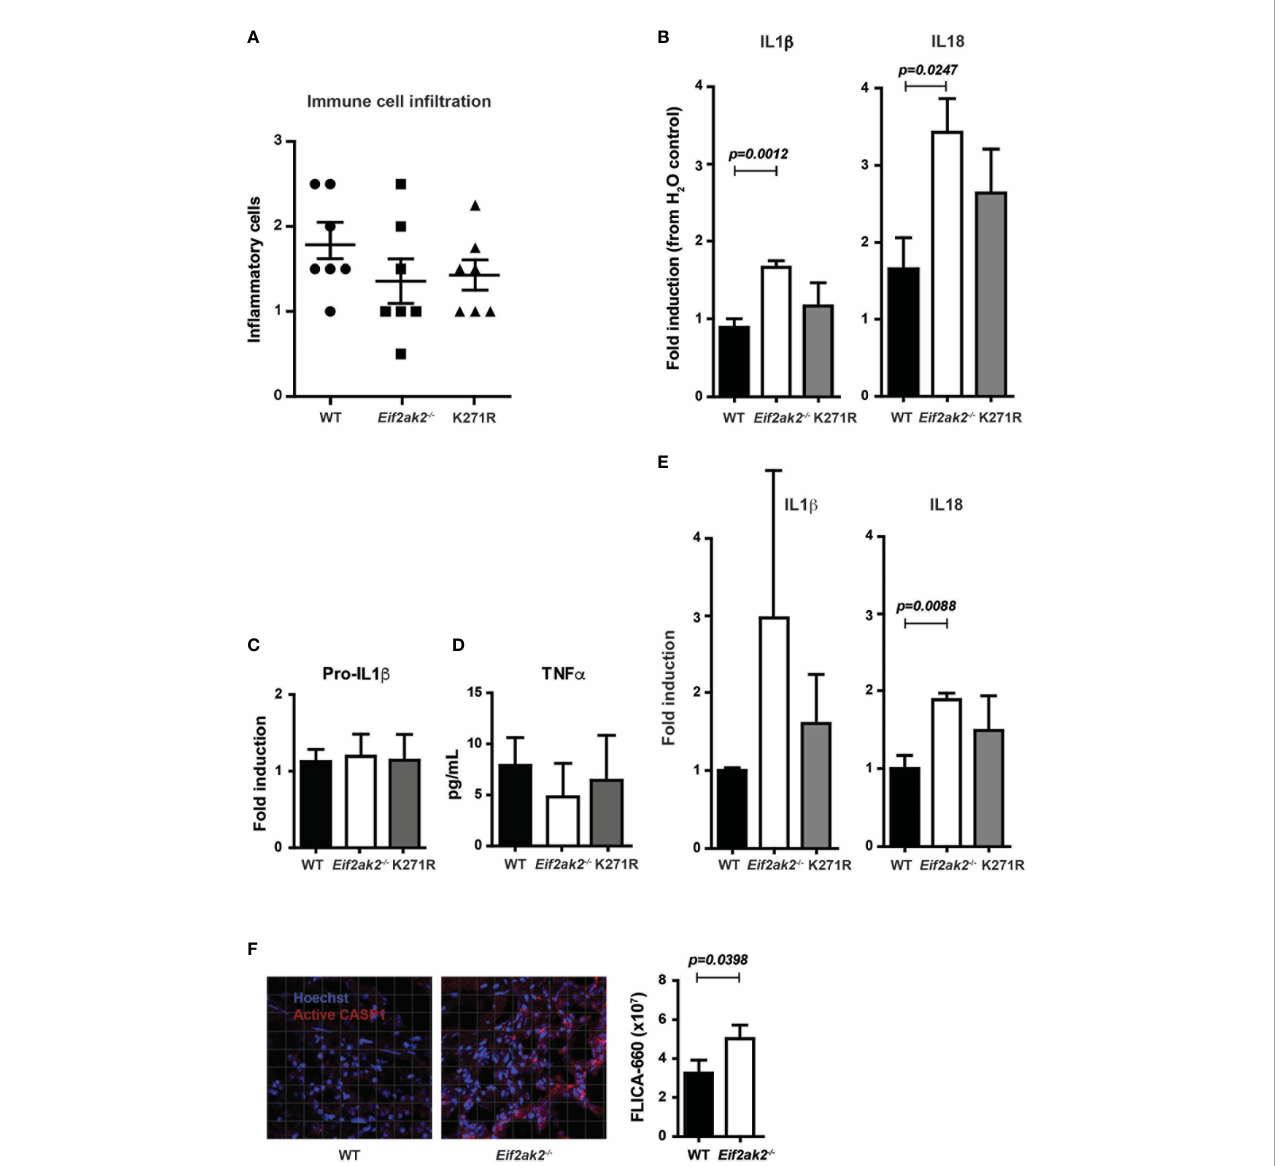
FIGURE 3 PKR limits DSS-induced in fl ammasome activity in the colon. (A-F) Analysis of in fl ammasome activity in WT, PKR-ablated ( Eif2ak2 -/- ) and kinase-dead (K271R) mice. (A) In fl ammatory cell in fi ltrates into the colons of mice treated with DSS for 5 days assessed from H&E-stained tissue sections (n=7). Data were collected from two independent experiments. (B) Quantitation of the relative levels of cleaved IL1 b and IL18 produced from colon explants of DSS- treated mice as detected by immunoblot (n=7). Data were collected from two independent experiments. (C) Induction of pro-IL1 b in colon explants measured by immunoblot and expressed relative to WT mice (n=4). Data were collected from four independent experiments and analyzed by one-way ANOVA with Tukey ’ s range test. (D) Levels of TNF a expressed from colon explant detected by ELISA (n=4). Data were collected from four independent experiments and analyzed by one-way ANOVA with Tukey ’ s range test. (E) Quantitation of the relative levels of cleaved IL1 b and IL18 produced from colon explants of untreated mice as detected by immunoblot (n=7). Data were collected from two independent experiments. (F) Micrographs of colon tissue from untreated mice stained for Casp1 activity (FLICA-660) (red) and counter stained with Hoechst to mark cell nuclei (blue). Casp1 activity is quantitated by fl uorescent confocal microscopy in the graph on the right (n=3). Data is expressed as mean ± S.E.M. and analyzed by unpaired